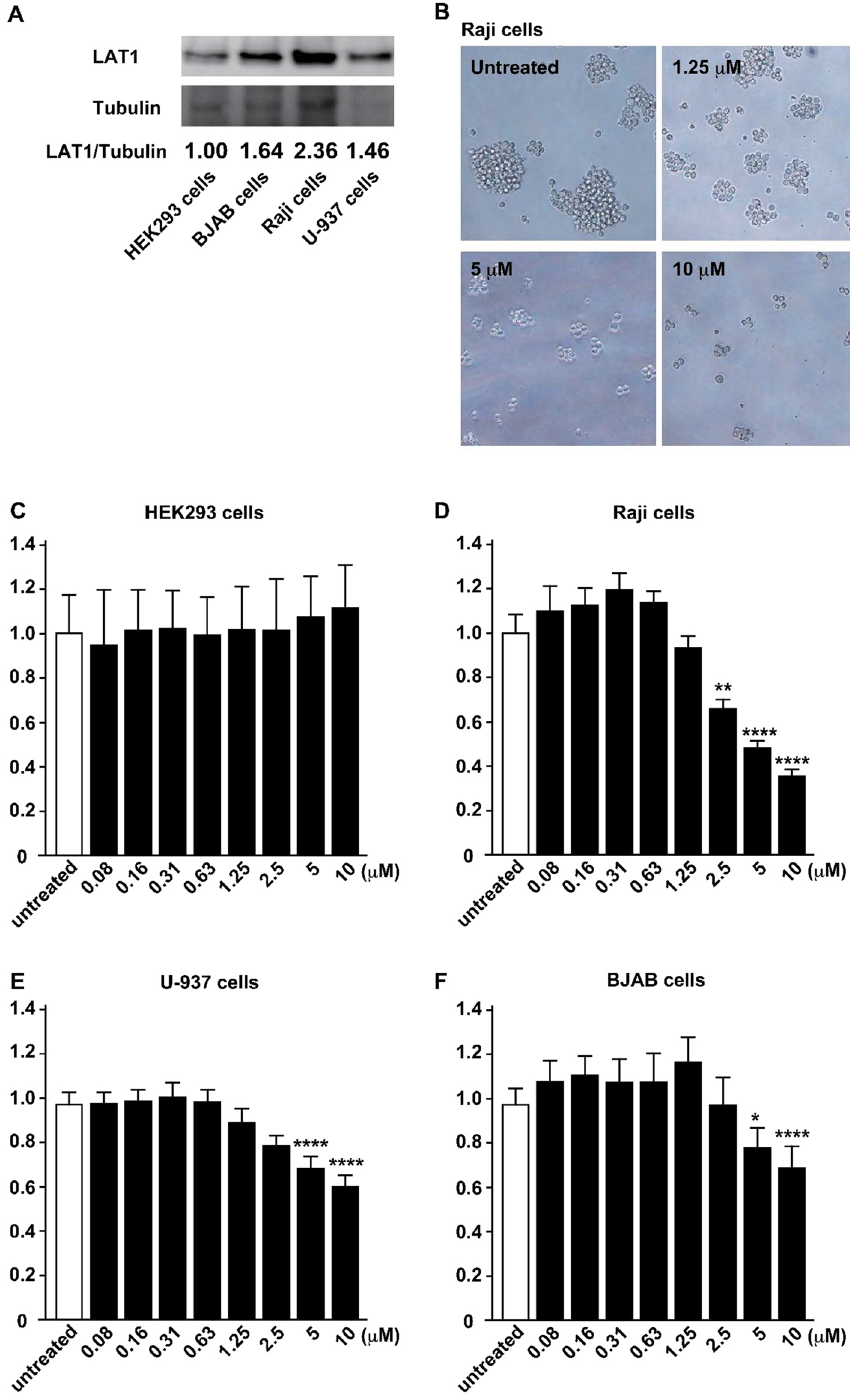
Figure 8. The effect of LAT1 inhibitor JPH203 on the viability of lymphoma cell lines and HEK293 cells. ( A ) Western blot analysis of LAT1 and tubulin. The LAT1/tubulin ratio was normalized to HEK293 cells. ( B ) Colony formation of Raji cells treated with the indicated concentration of JPH203. ( C – F ) The viability of Raji cells, BJAB cells, U-937 cells and HEK293 cells were analyzed after 8 different dozes of JPH203 treatment for 72 h and determined by Cell-titer glo 2. Significant cell death was observed at the concentration of 2.5 µM, 5 µM and 10 µM of JPH203 in Raji cell line. *P < 0.05; **P < 0.01; ****P <